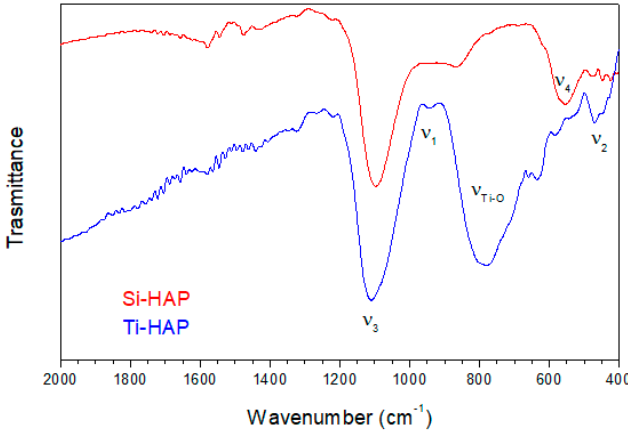
Figure 2. FTIR spectra of the pristine HAP samples.